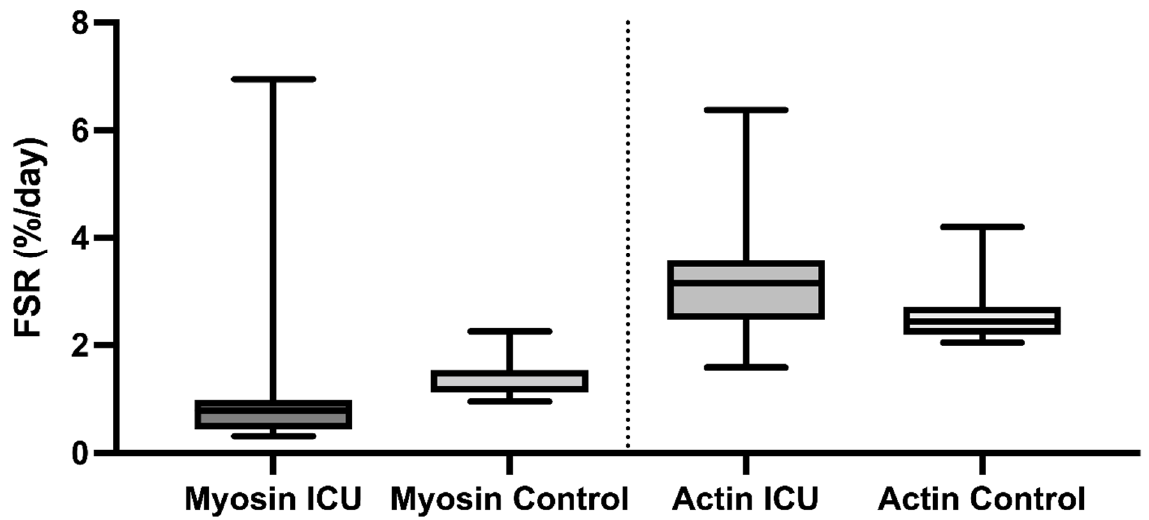
Figure 3. Fractional synthesis rates (FSRs) of myosin and actin from skeletal muscle in critically ill patients (ICU) and healthy controls (patients undergoing elective minor surgery) measured in only one leg. Individual values are given as dots and median values by the lines. Groups were compared using a Mann–Whitney U